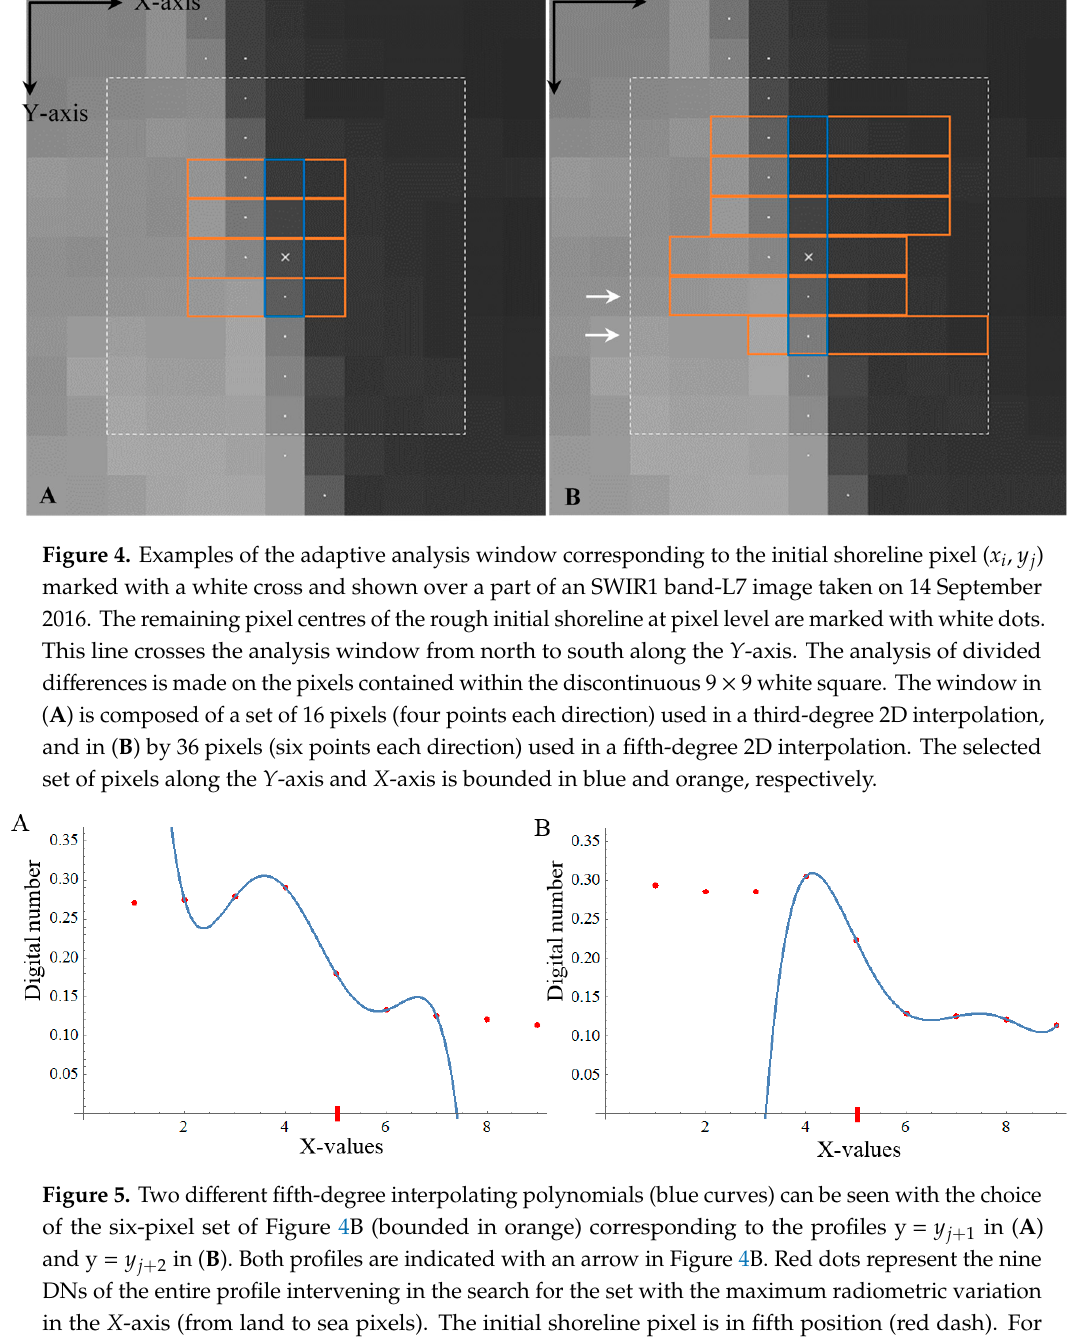
Figure 5. Two different fifth-degree interpolating polynomials (blue curves) can be seen with the choice of the six-pixel set of Figure 4B (bounded in orange) corresponding to the profiles y = y j + 1 in ( A ) and y = y j + 2 in ( B ). Both profiles are indicated with an arrow in Figure 4B. Red dots represent the nine DNs of the entire profile intervening in the search for the set with the maximum radiometric variation in the X -axis (from land to sea pixels). The initial shoreline pixel is in fifth position (red dash). For simplicity, X-coordinates are transformed to a scale of between 1 and 9.